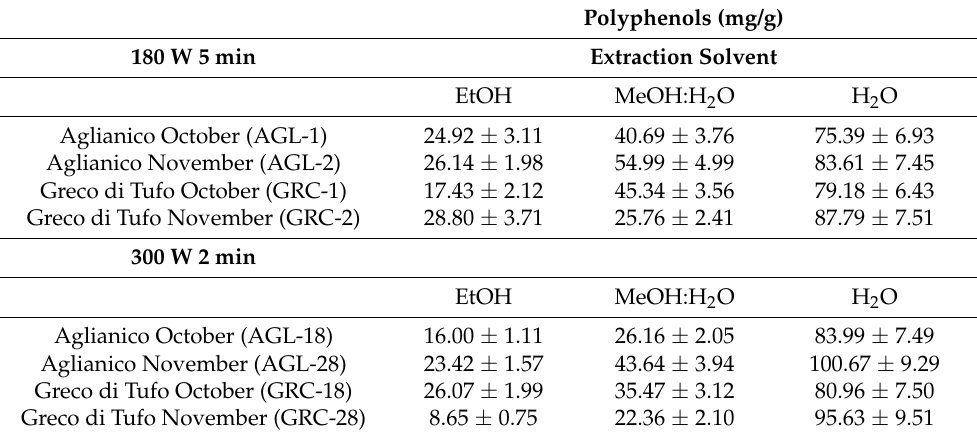
Table 3. Polyphenol concentrations in Vitis vinifera ‘Aglianico’ and ‘Greco di Tufo’ leaves (mg/g of leaf powder extract) after MAE with different solvents and extraction conditions. Ethanol extract (EtOH), methanol:water extract 70:30 (MeOH:H 2 O), water (H 2 O)